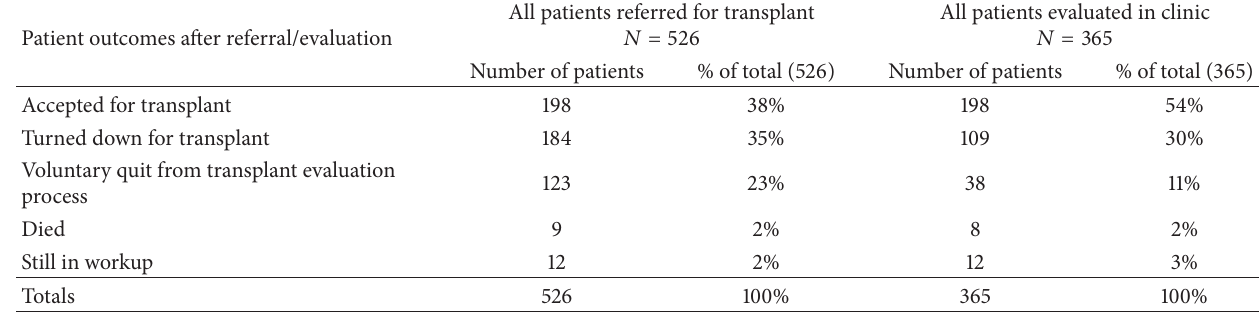
Table 2: Summary of patients and their referral/evaluation outcomes.